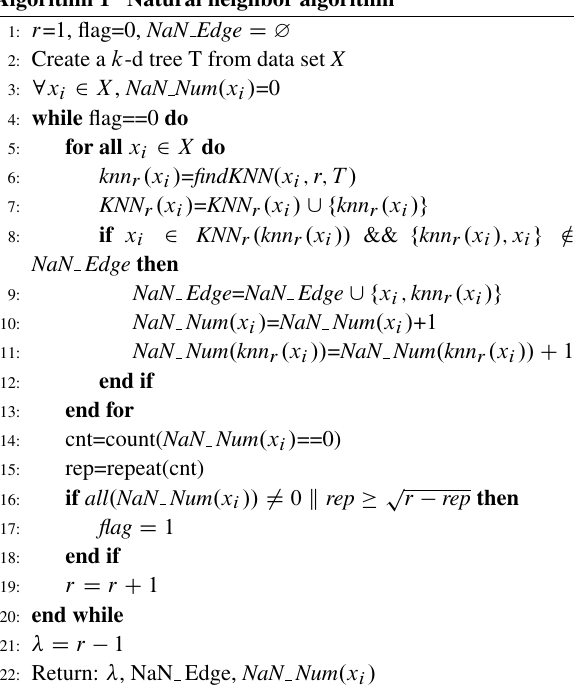
Algorithm 1 Natural neighbor algorithm